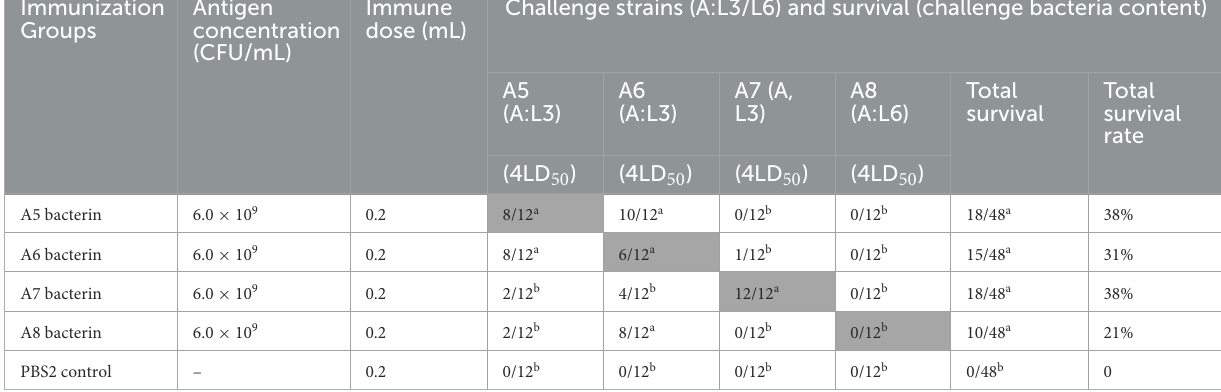
TABLE 3 Protection rate of A5–A8 bacterins against P. multocida strains (Test-2). Immunization